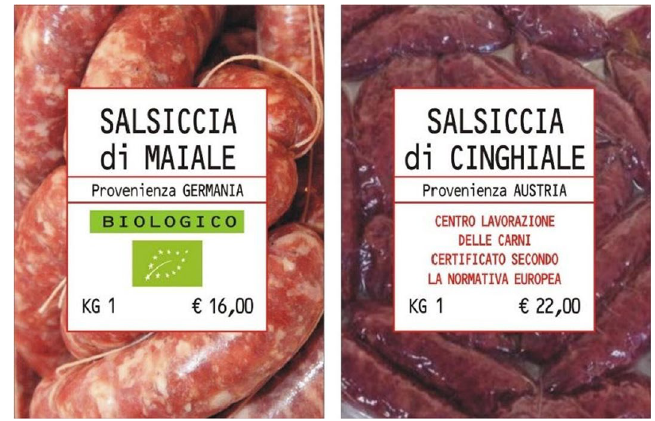
Fig. 2 An example of scenario proposed in the choice